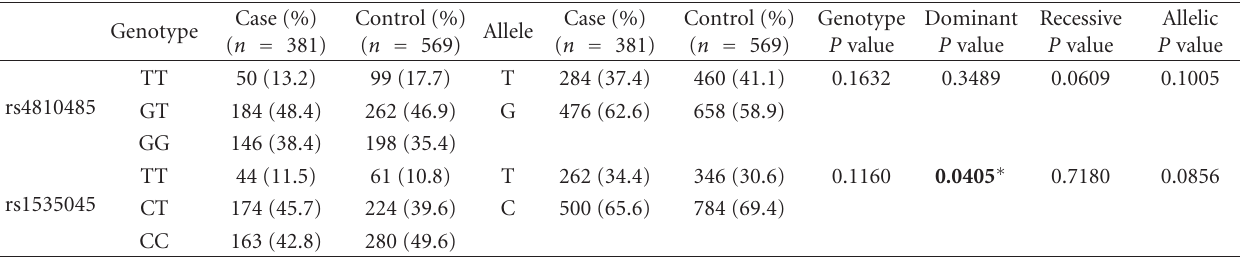
Table 2: Genotype and allele frequencies of the CD40 gene in controls and patients with Kawasaki disease.